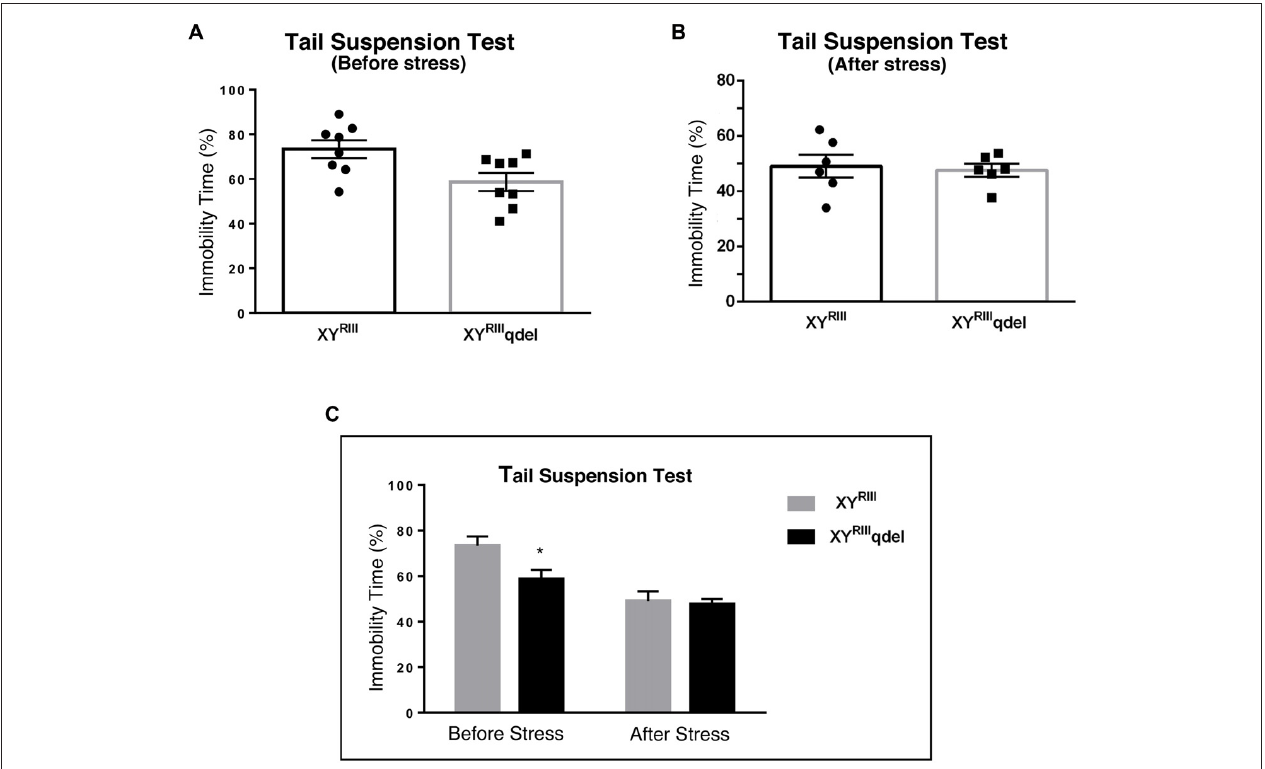
FIGURE 3 | The status of depression in XY RIII qdel and XY RIII mice was evaluated by tail suspension test before and after the exposure of the stressors. Before the mice have undergone stress paradigm, XY RIII qdel exhibited significant hyperactivity by showing remarkable less immobility time in percentage out of total test period (A,C) . Please notice after stress this hyperactivity was leveled as shown by scatter bar plot (B) of the same test. Combined bar graph is shown to compare the effect of before and after stress for the same parameter (C) . Data are expressed as the mean ± SEM, ∗ P < 0.05, n = 8–10 per group in before stress, n = 6–8 per group in after stress